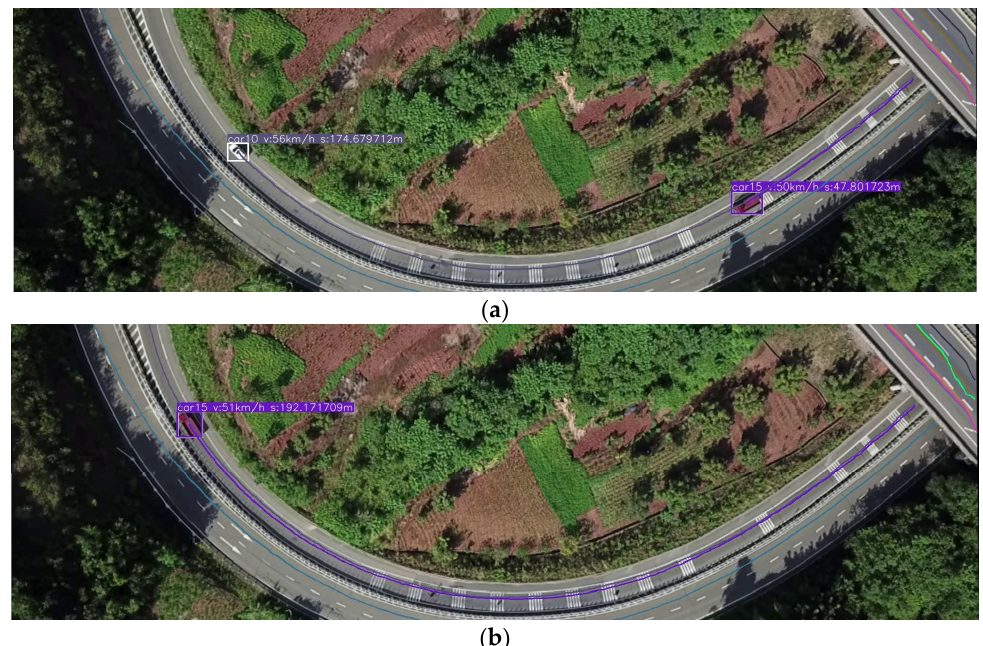
Figure 5. Registration effects: ( a ) trajectory of previous frame after registration; ( b ) trajectory of later frame after registration.